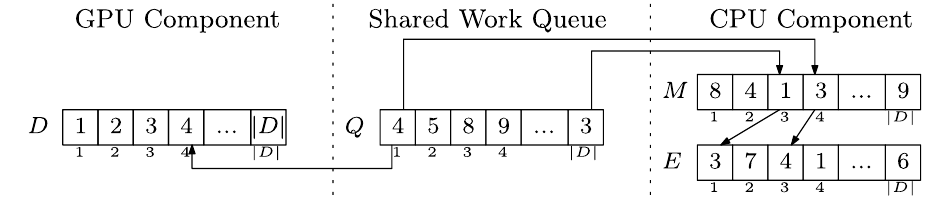
Fig. 3 Illustration of an input dataset D , the shared deque sorted by workload Q , the input dataset EGo -sorted E and the mapping M between Q and E . The numbers in D , Q , and E correspond to query